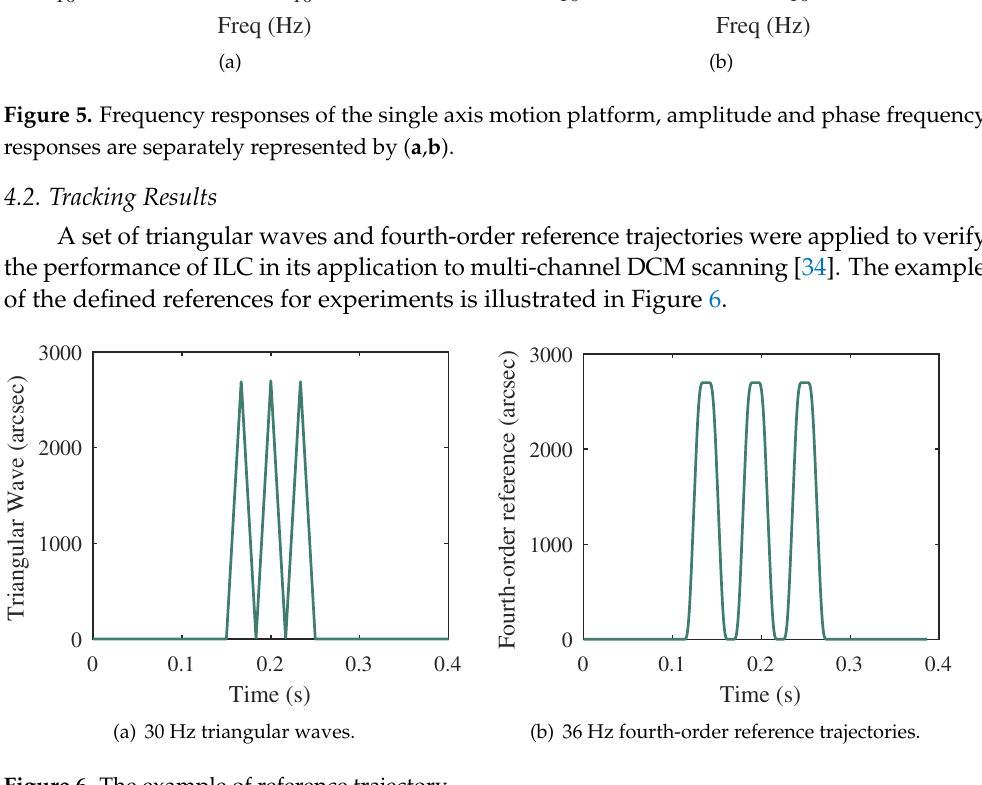
Figure 6. The example of reference